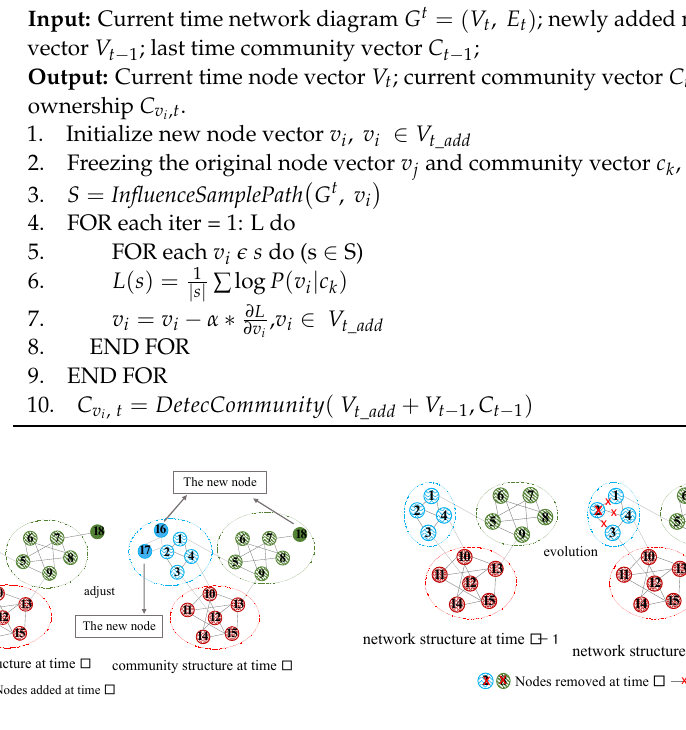
community structure at time  network structure at time